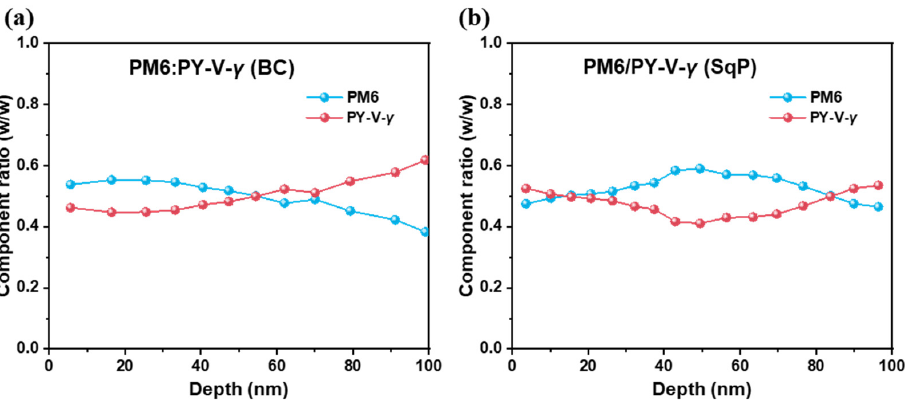
Figure 5. The composition ratio across the vertical direction of the active layer for BC PM6:PY-V- γ ( a ) and SqP PM6/PY-V- γ ( b ).